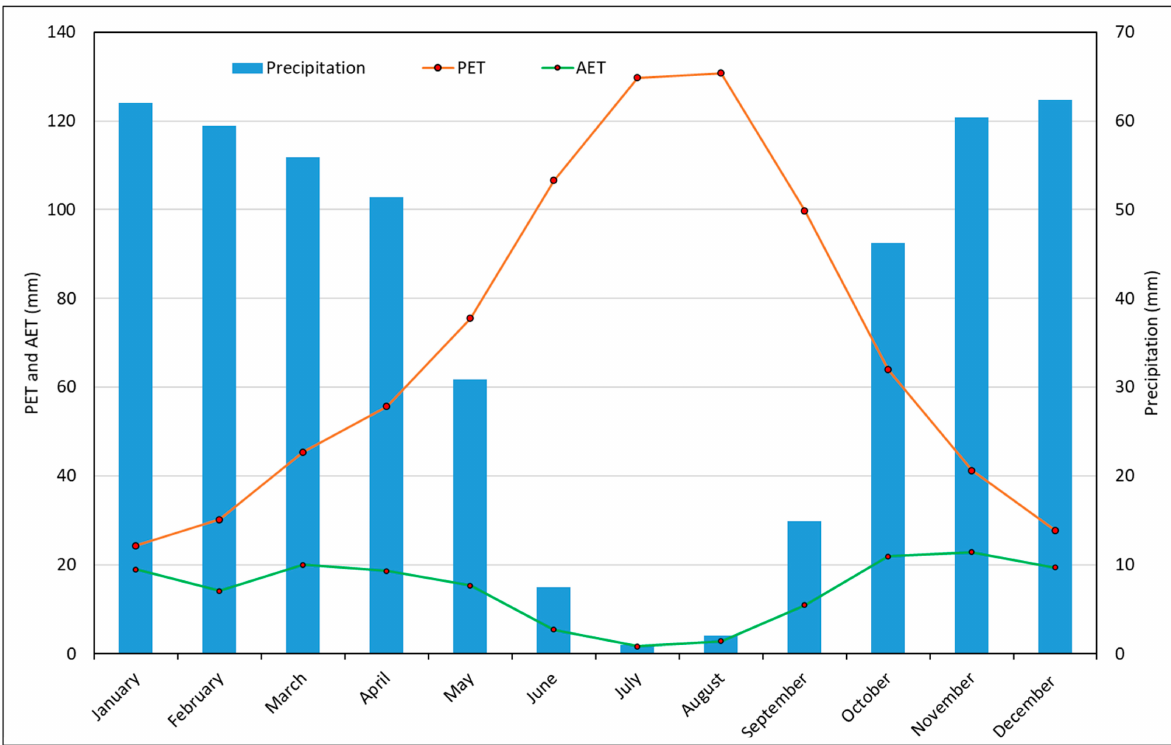
Figure 3. Climate water balance in the Saïss plain (1988–2021) .